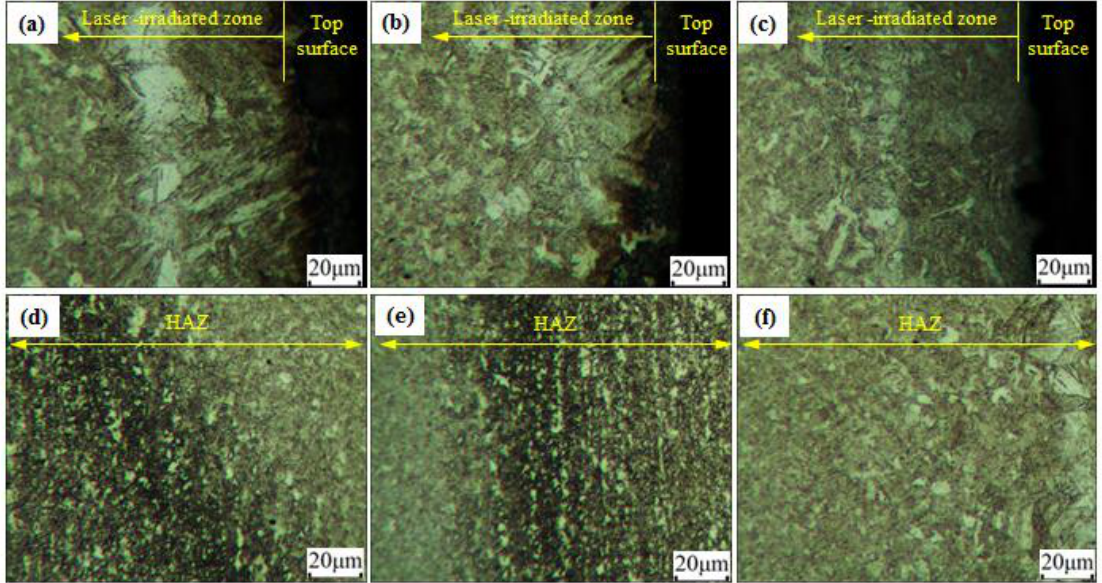
Figure 10. Microstructures in the thickness direction of the plate: ( a ) and ( d ) 280W, 10mm/s; ( b ) and ( e ) 280W, 20mm/s; ( c ) and ( f ) 280W,